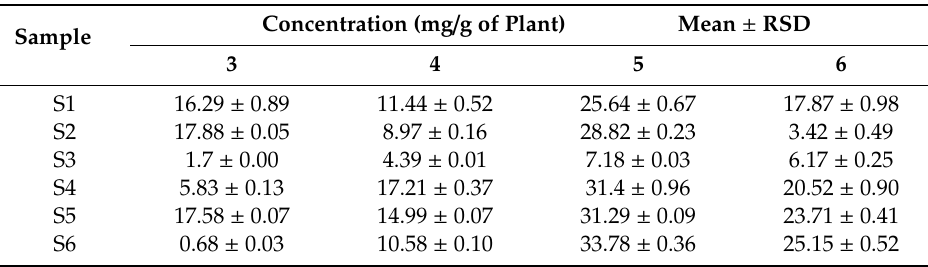
Table 2. Contents of verbenaline (3), hastatoside (4), verbascoside (5) and hispidulin 7O β GH (6) in six samples of V. carolina